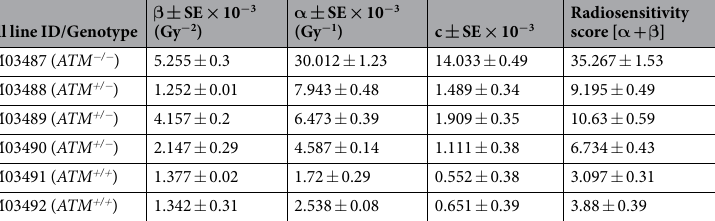
Table 1. Individual radiosensitivity coefficients ( α , β , c, and α + β ) in primary fibroblasts from an A-T-affected family. α , β , and c coefficients were extracted from dose-response calibration curves in Fig. 1(e) using Cabas software. α + β is equivalent to IR-induced micronucleus formation upon γ -ray irradiation at 1 Gy.